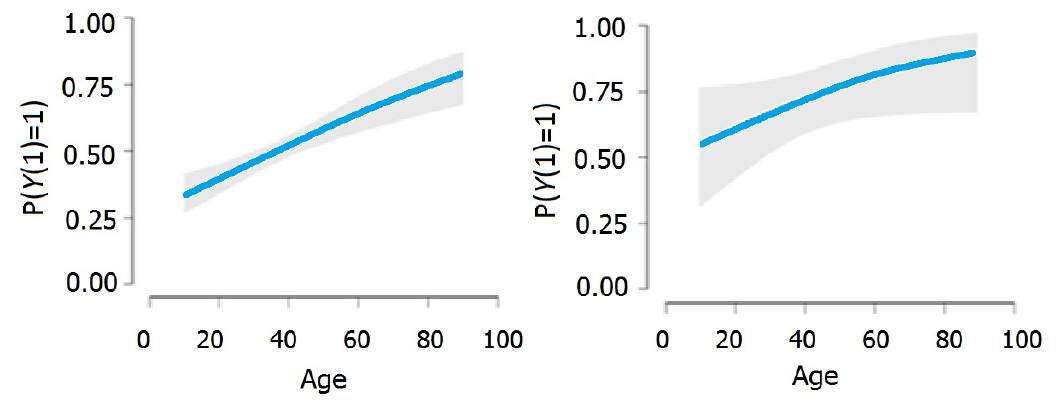
Figure 1. The relationship between age and the dependent variable Y 2 in both models Figure 2 confirms the importance of preventive measures against COVID ‐ 19 infection for vaccinated people. This may be observed in the range between 𝑋 (cid:2869) and 𝑋 (cid:2870) .